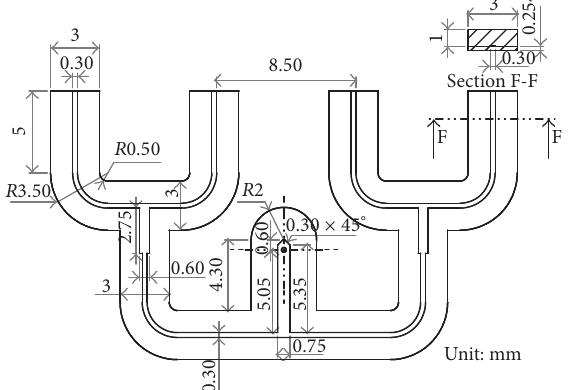
Figure 3: Structures of Region I in the feeding network.